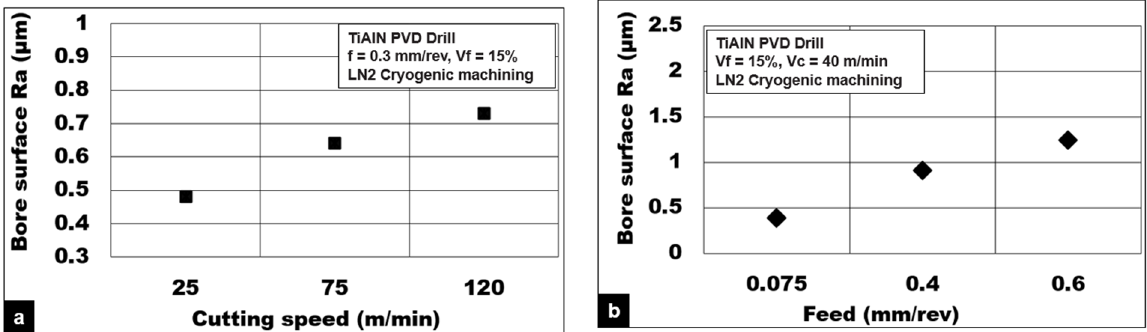
Figure 8. Influence of process parameters: ( a ) drilling speed and ( b ) feed on average surface roughness (Ra) during drilling Mg-9Al-1.4Zn-15% hollow Al 2 O 3 foam.